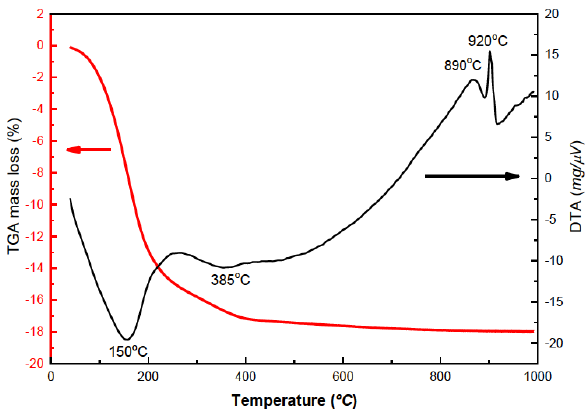
Figure 2: TGA plots of per cent mass loss and DTA for LTA zeolite powders synthesized showing the change in the zeolite structure as a function of